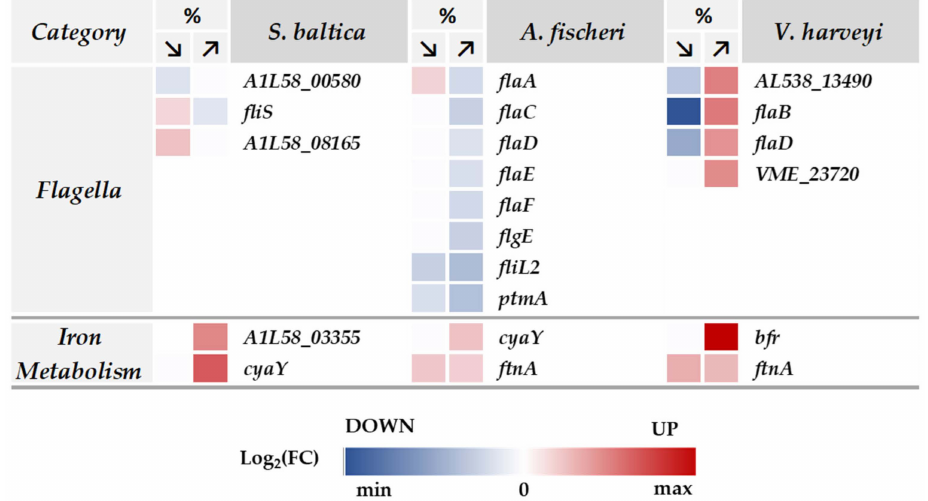
Figure 7. Heatmaps of expression of flagella- and iron metabolism-related proteins in S. baltica , A. fischeri , and V. harveyi following low- and high-salinity stress. In the header, upwards- and downwards-pointing arrows indicate low- and high-salinity conditions, respectively. The hue of blue or red colors indicates the change in level (log 2 -transformed fold change (FC) values) of selected proteins relative to optimal salinity; the corresponding gene names are used to designate proteins. Exact protein fold change values can be found in Supplementary Table